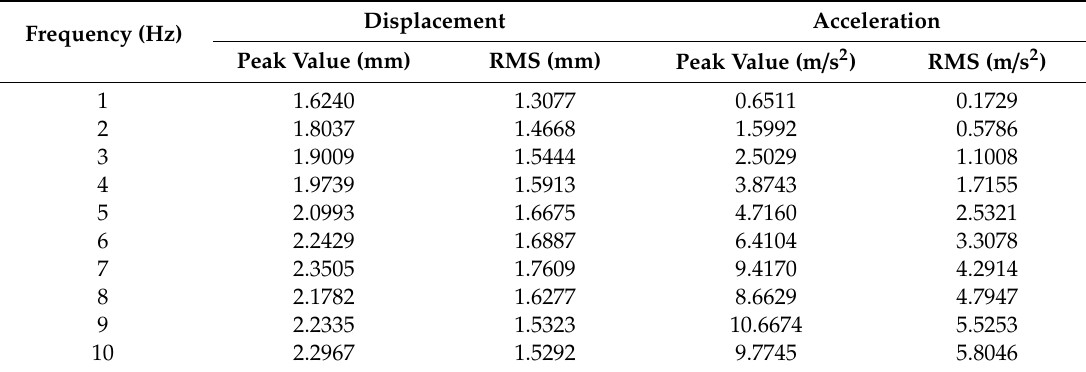
Table 1. Vibration response of the pipeline without control.